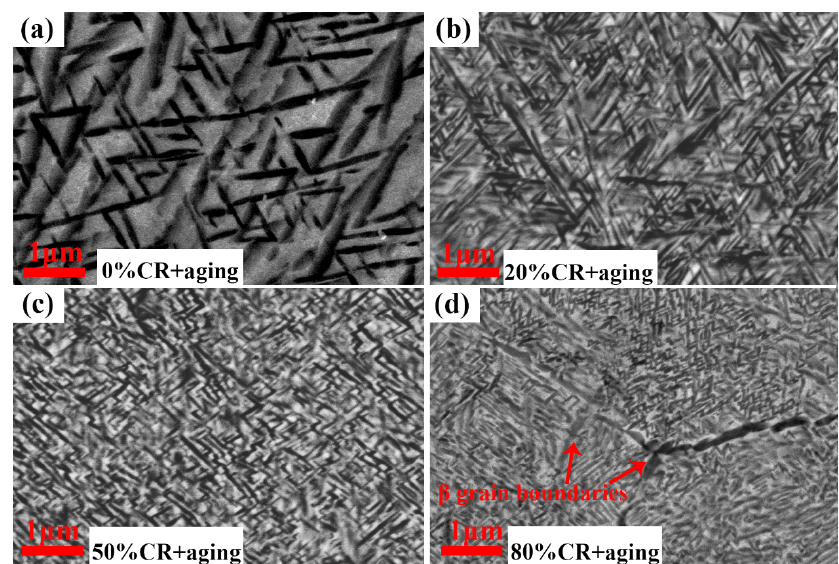
Figure 6. SEM images of the solution-treated sample and cross-rolled samples aged at 600 °C for 1 h. ( a ) 0% + aging, ( b ) 20% + aging, ( c ) 50% + aging, ( d ) 80% + aging. ( a ) 0% + aging, ( b ) 20% + aging, ( c ) 50% + aging, ( d ) 80% + aging.